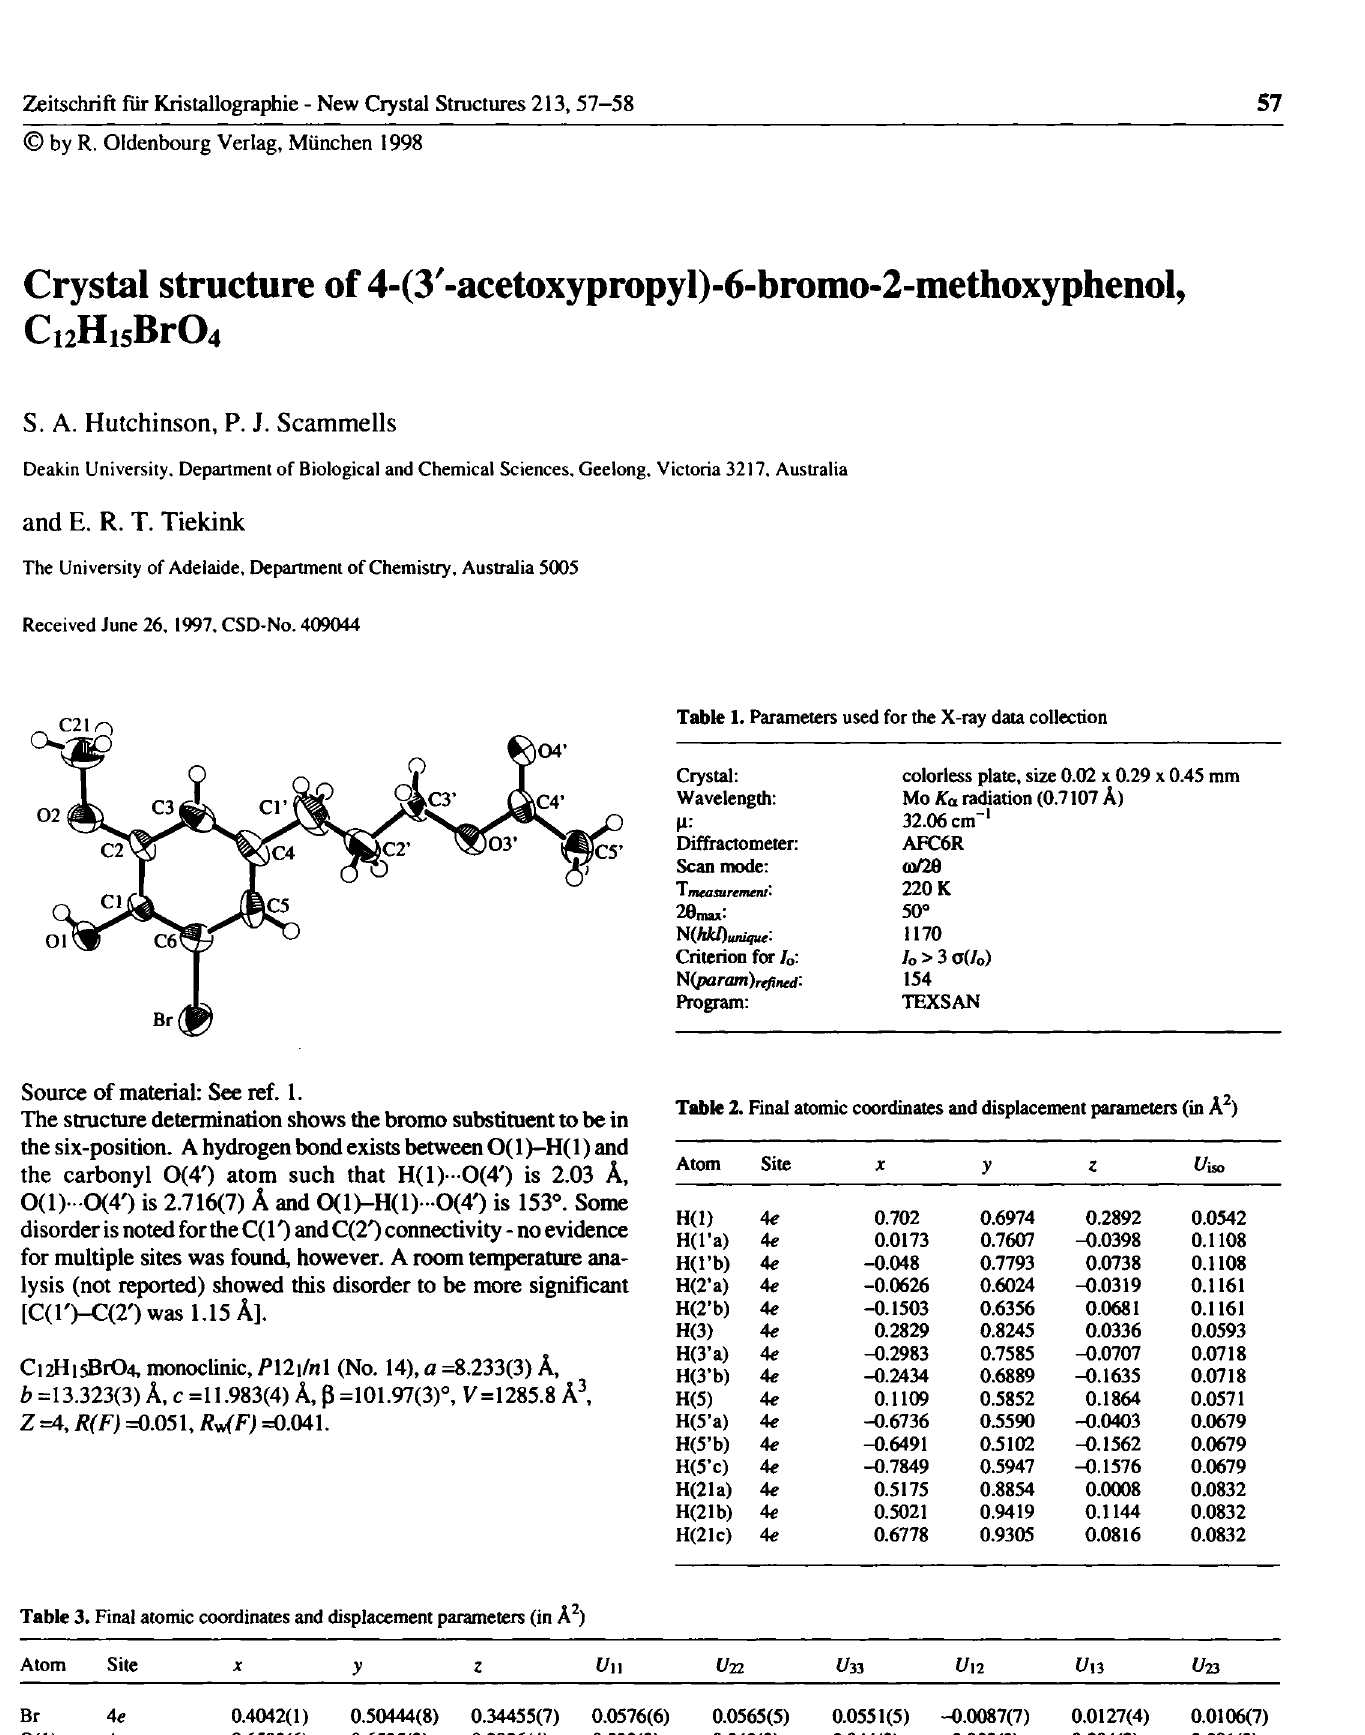
Table 3. Final atomic coordinates and displacement parameters (in A^)